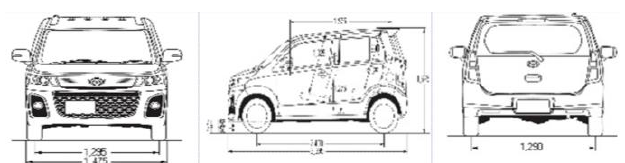
Fig. 5. Blueprints of Daihatsu Mira X (a) Front view (b) Side view (c) Back view